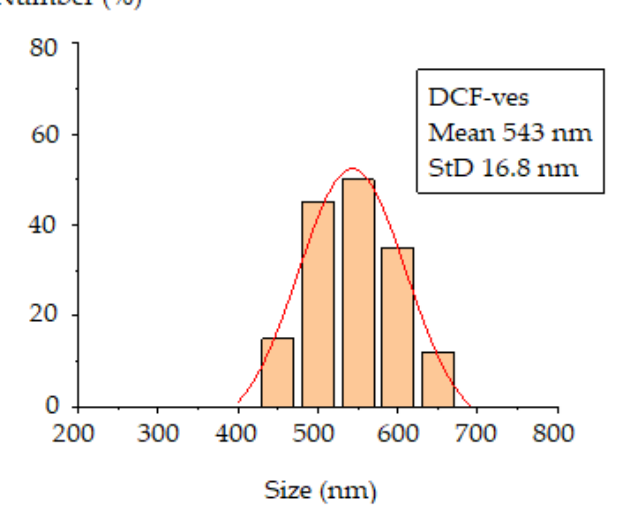
Figure 4. The dimensional histogram of DCF-ves coated with chitosan.